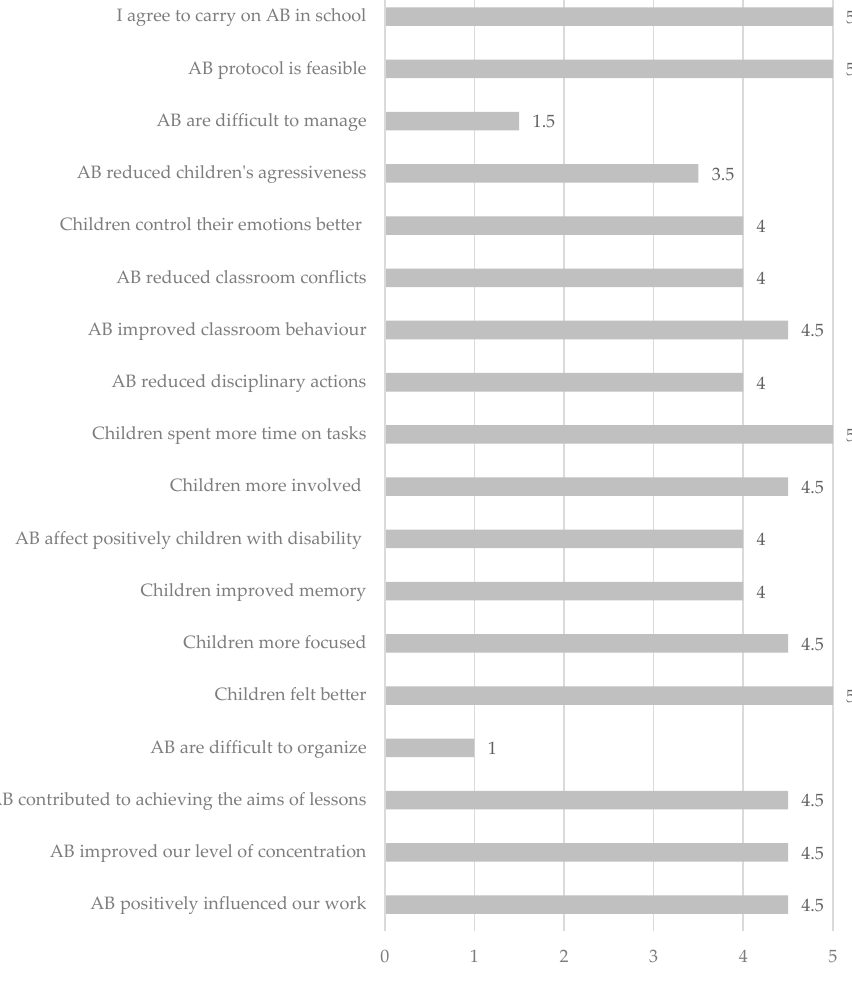
Figure 4. Teachers’ answers to the AB questionnaire.